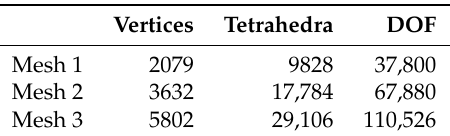
Table 2. The number of vertices, tetrahedra and degrees of freedom (DOF) of fluid–structure linear system for each